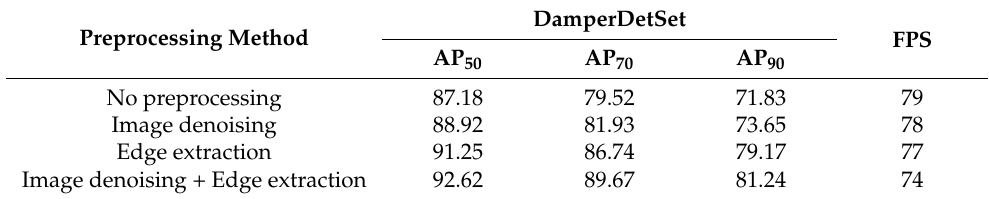
Table 4. APs of different preprocessing methods.